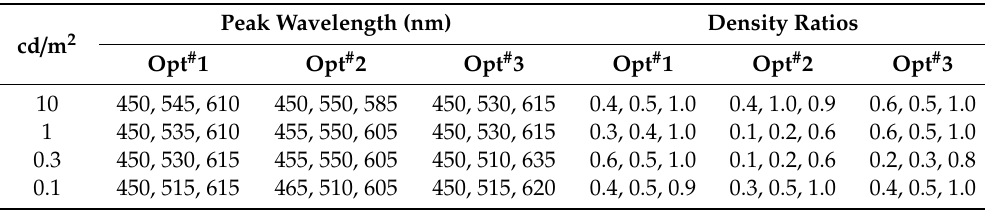
Table 2. Information of optimal spectra.